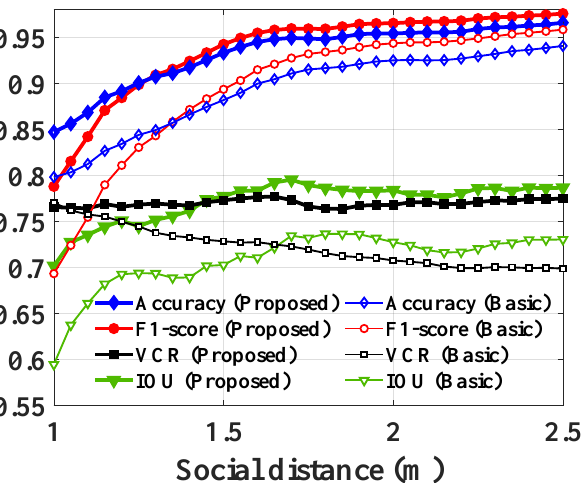
Figure 7. The performance evaluation results in terms of accuracy, F1-score, VCR, and IOU averaged across all video sequences and plotted for a range of social safety